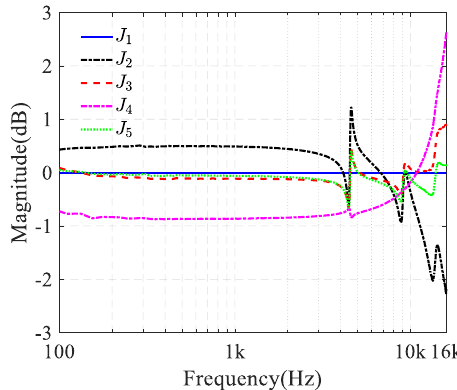
Figure 3. (Color online) The measured J 1 to J 5 used for compensating the microphone mismatch in the proposed five-microphone array.